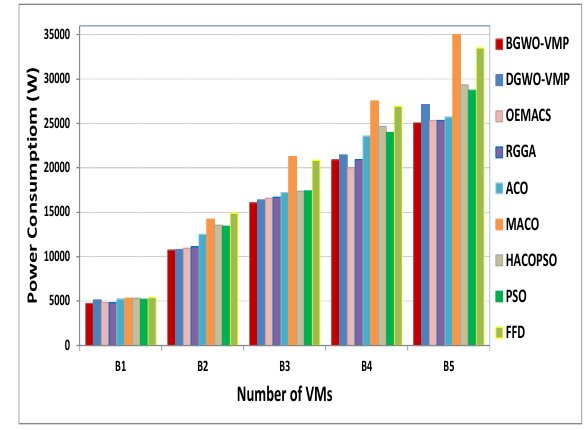
Figure 8. Power consumptions of various algorithms in the heterogeneous